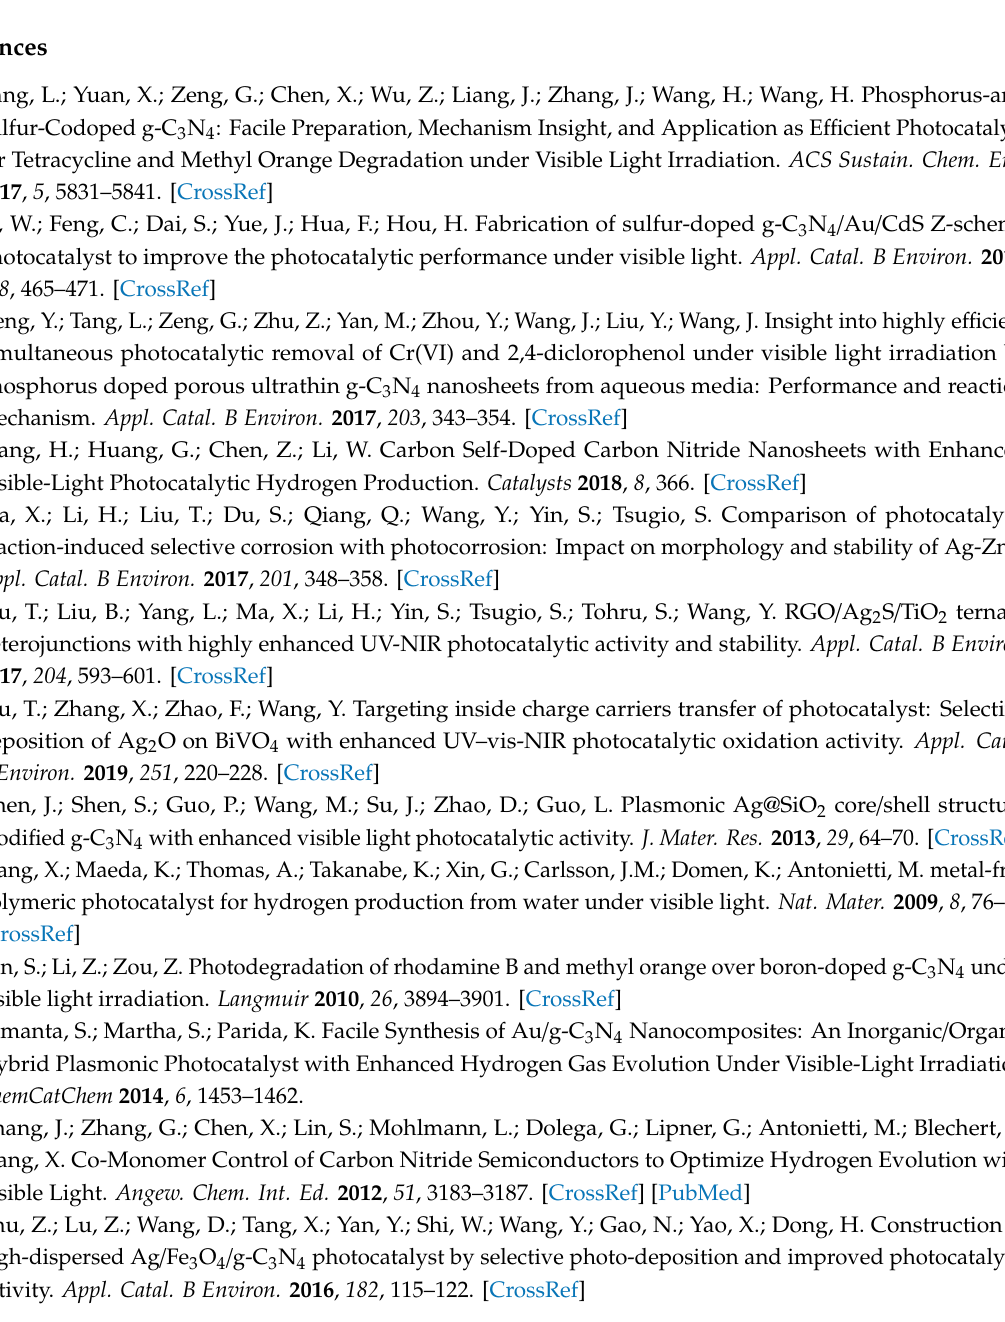
Figure S1: TEM images of g-C 3 N 4 (a), P-g-C 3 N 4 (b), 3% Au / g-C 3 N 4 (c), 1% Au / P-g-C 3 N 4 (d), 3% Au / P-g-C 3 N 4 (e) and 5% Au / P-g-C 3 N 4 (f), Figure S2: N 2 adsorption-desorption isotherms of g-C 3 N 4 , P-g-C 3 N 4 and 3% Au / P-g-C 3 N 4 , Figure S3: XRD patterns of fresh and used 3% Au / P-g-C 3 N 4, Figure S4: XPS spectrum and TEM photograph of used 3% Au / P-g-C 3 N 4